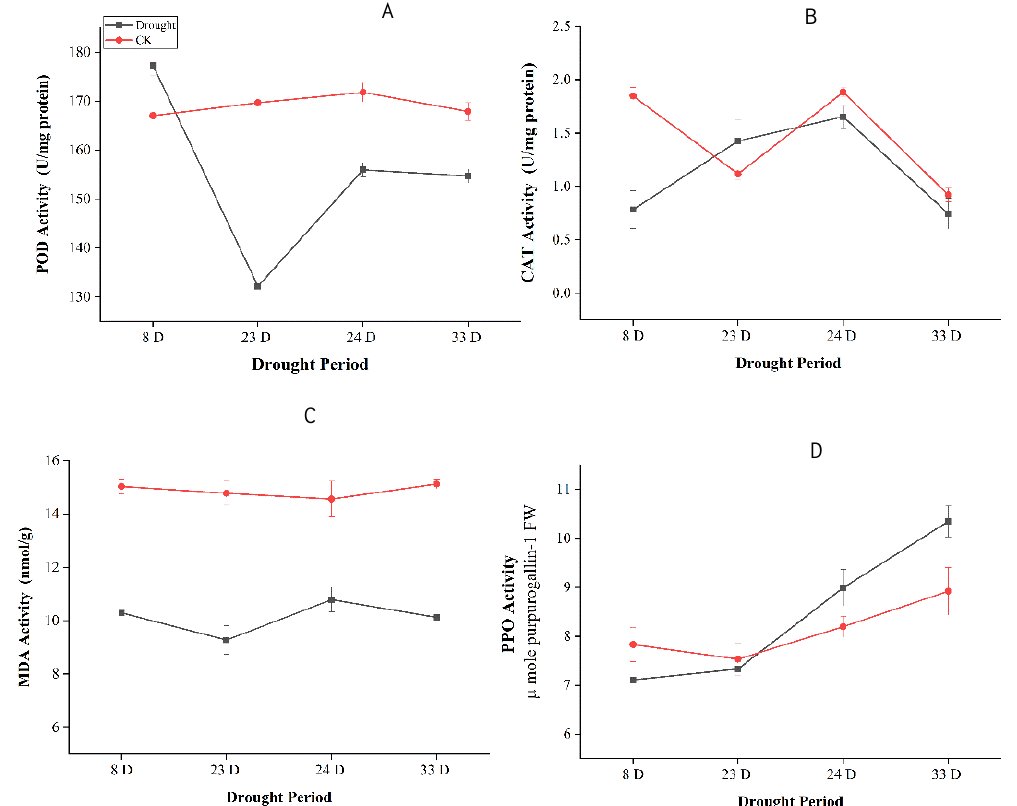
Figure 2. Antioxidant enzyme activities in Pinus tabuliformis leaf during drought stress and recovery of (Drought: 8 days, 23 days, Rewatering: 24 days and Recovery: 33 days) ( A ) Peroxidase (POD), ( B ) Catalase (CAT), ( C ) Malondialdehyde (MDA) content, and ( D ) Polyphenol oxidase (PPO).